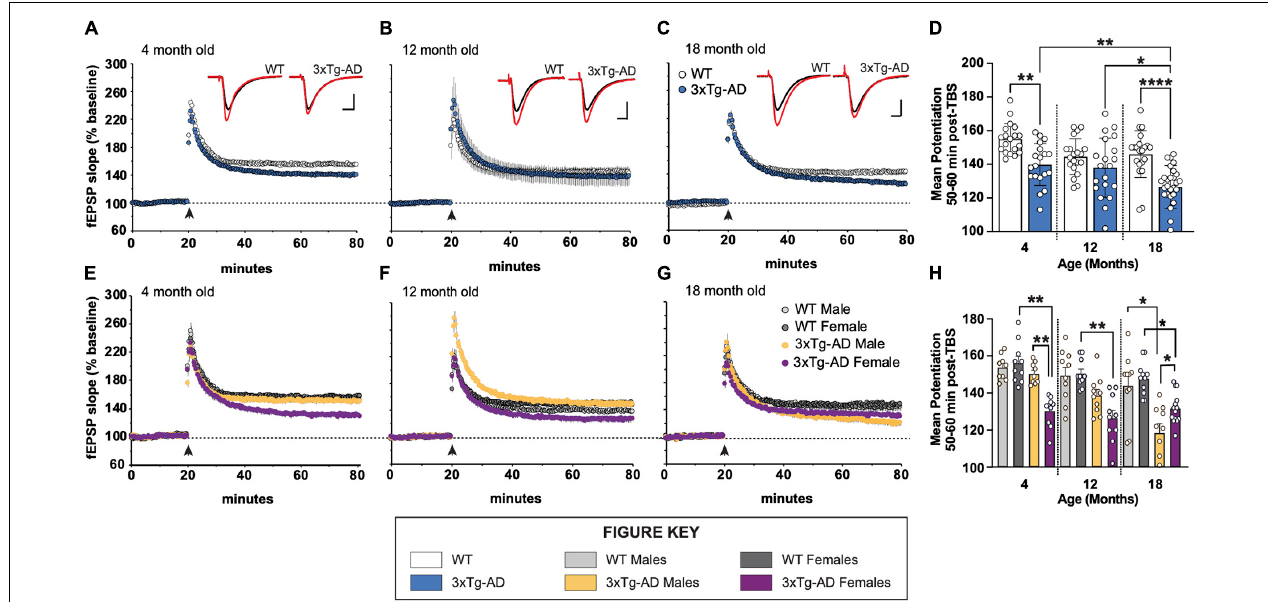
FIGURE 1 | Long-term potentiation (LTP) impairments in 3xTg-AD mice at ages 4, 12, and 18 months in a sex-dependent manner. (A–C,E–G) Hippocampal slices were collected from 4-, 12-, and 18-month-old (mo) male and female WT and 3xTg-AD mice and were used to measure LTP in the stratum radiatum in area CA1. Following a 20 min stable recording of field excitatory postsynaptic potentials (fEPSP), LTP was induced by applying five theta bursts (black arrow: each burst containing four 100 Hz pulses with each burst separated by 200 ms) and recording of baseline stimulation was resumed for an additional 60 min. (D,H) fEPSP potentiation averaged during the last 10 min of recording in slices from male and female WT and 3xTg-AD mice at ages 4, 12, and 18 mo. * p < 0.05, ** p < 0.005, **** p <